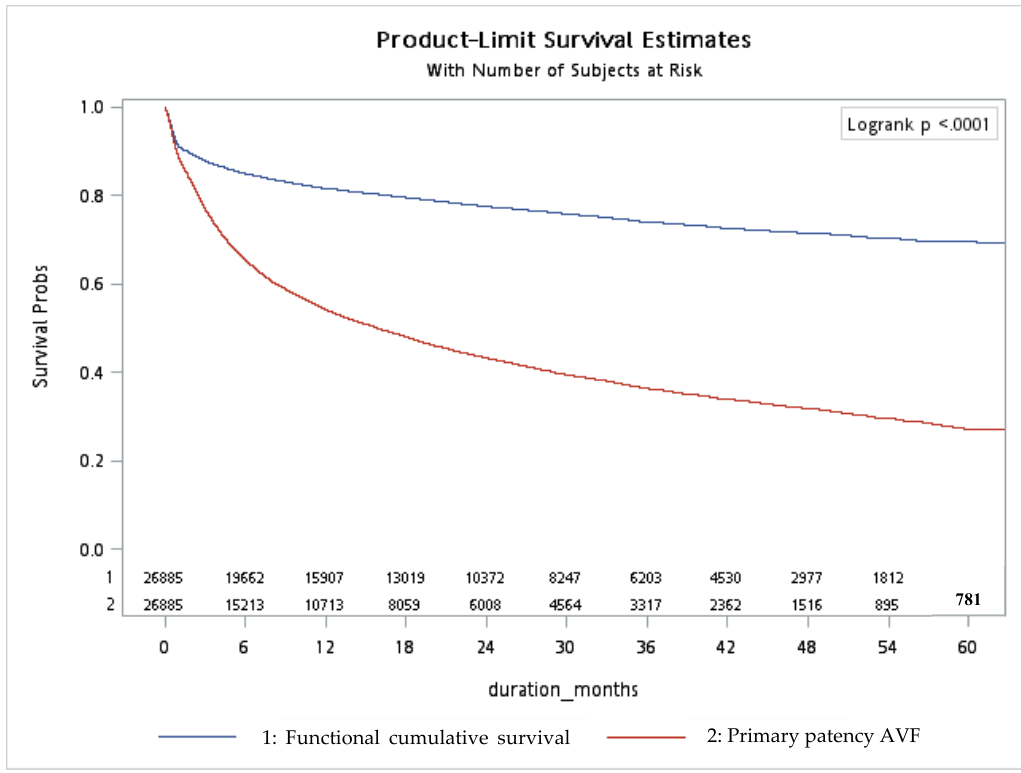
Figure 3. Functional cumulative survival and primary patency of fistulas.